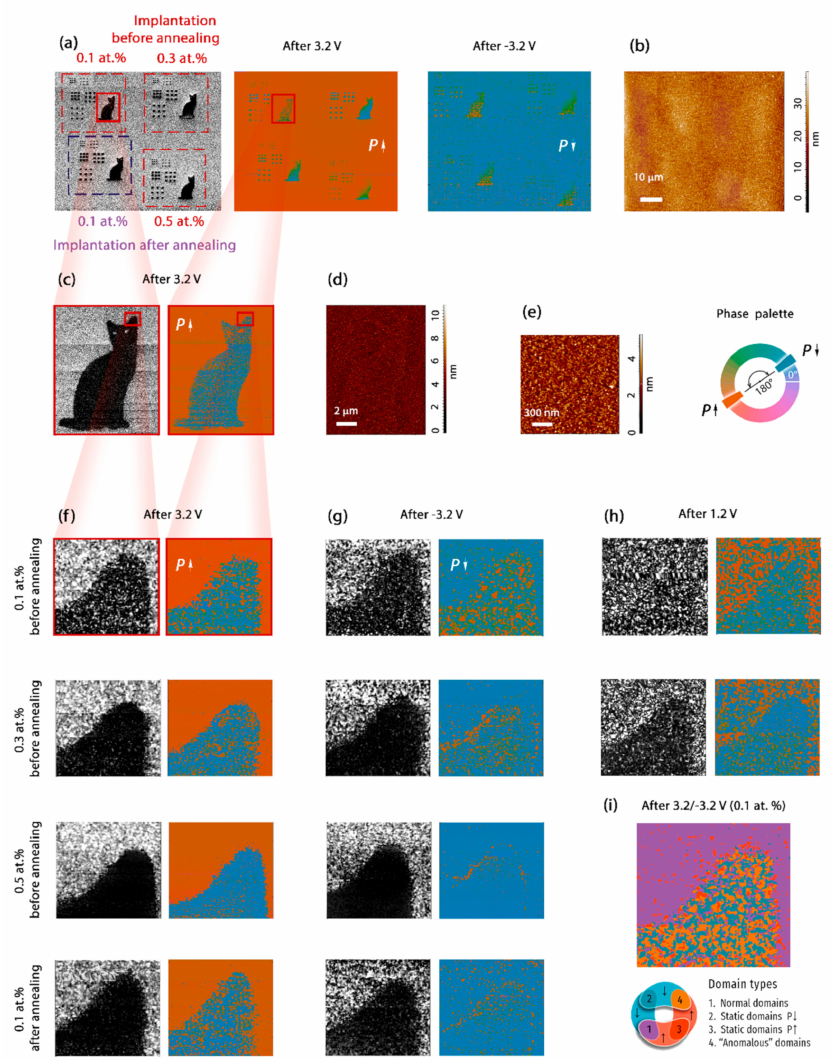
Figure 3. Domain switching within native HZO and regions doped with various Ga concentra- tions; gray-colored maps are the PFM amplitude maps, orange-blue maps are the PFM phase maps. The phase palette is common to all the PFM phase maps. ( a ) Domain structure at low magnification. ( b ) Topography of the top TiN electrode at low magnification. ( c ) Domain structure at medium magnification. ( d , e ) Topography of the top TiN electrode at medium and high magnification. ( f – h ) Domain structure at high magnification of the regions doped with some Ga concentrations after applying 3.2, − 3.2 and 1.2 V. ( i ) Identification of four types of domain within the region doped with 0.1 at.% (obtained by overlaying the PFM-phase maps in ( f , g